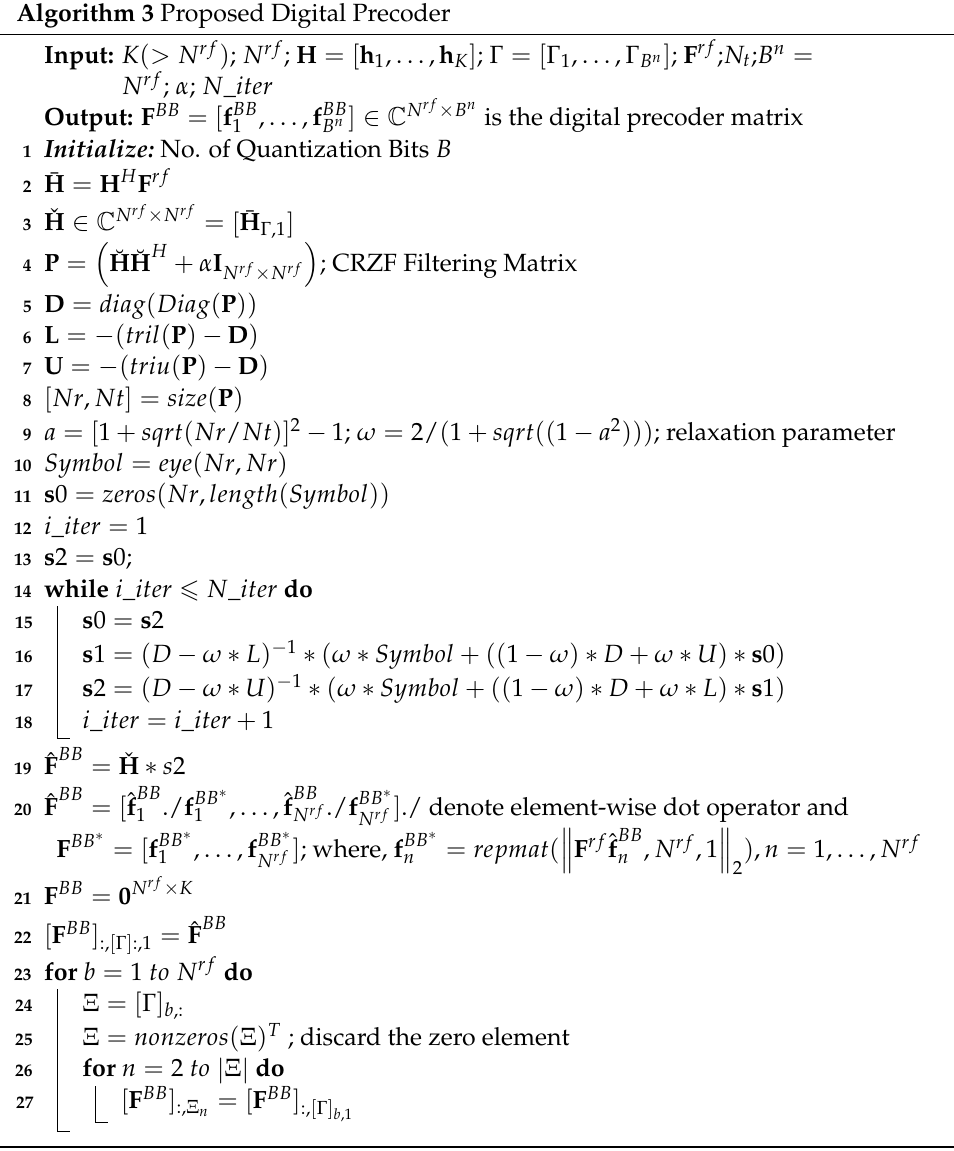
Algorithm 3 Proposed Digital